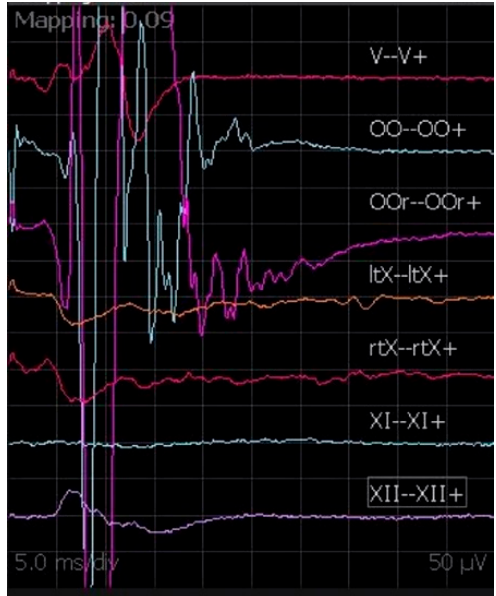
Figure 8. DES during vestibular schwannoma surgery, with muscular activation of OOr and